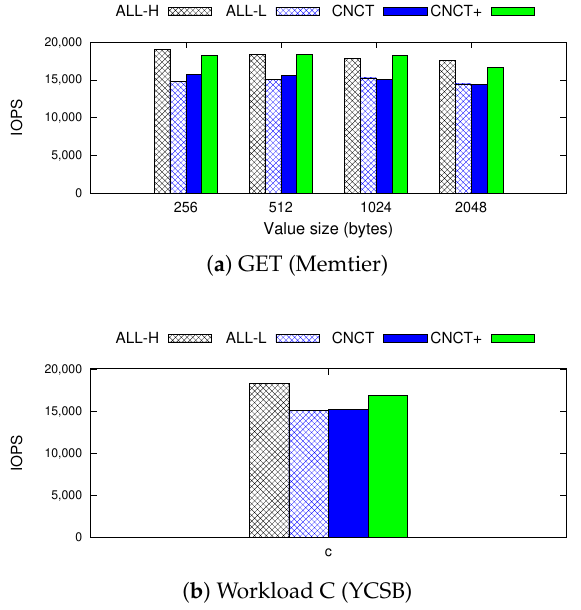
Figure 9. Read performance for